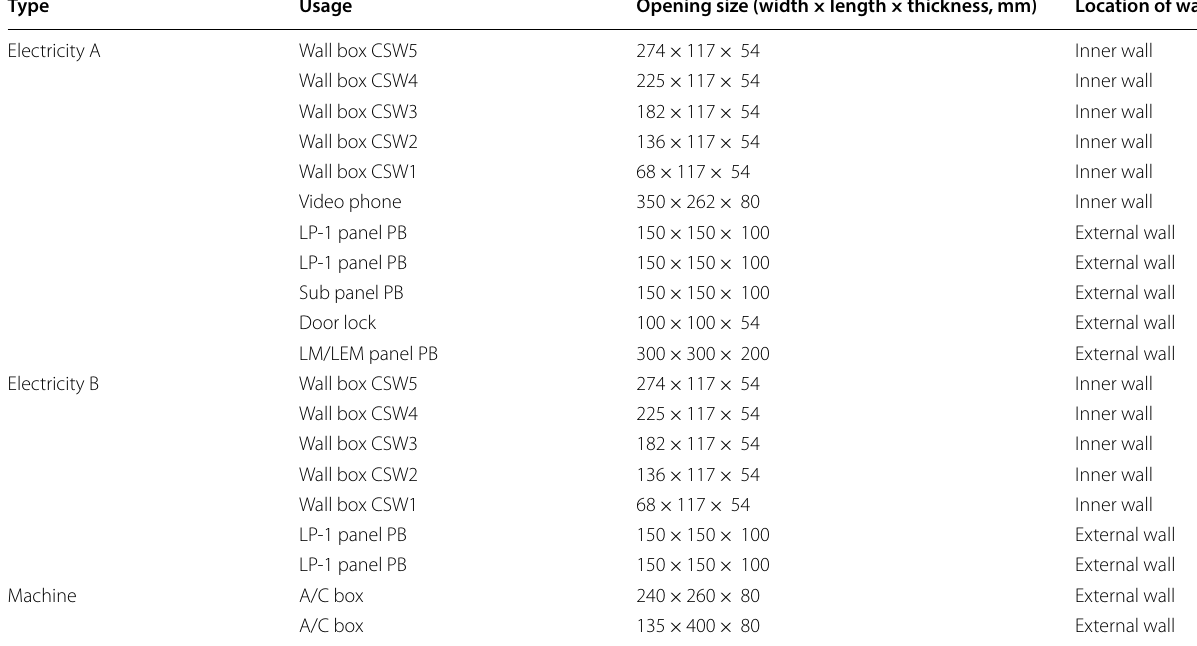
Table 1 Types of small